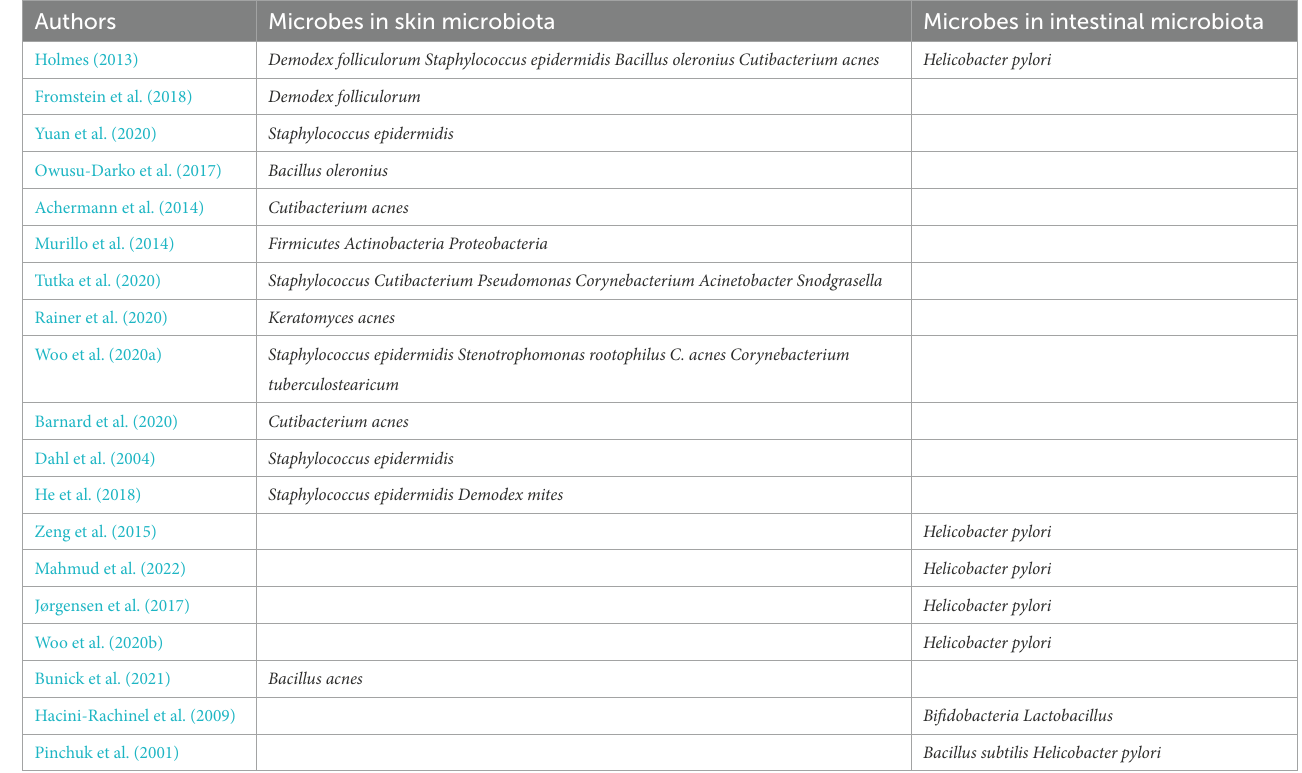
TABLE 1 Some microorganisms closely related to rosacea in intestinal microbiome and skin